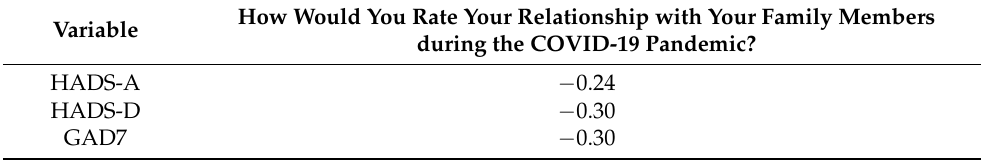
family using Pearson correlation coefficient, (results in bold at p < 0.05).